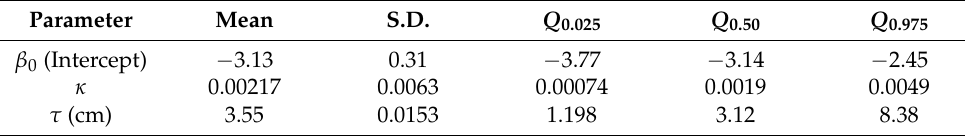
Table 1. Posterior distribution of the parameters using the complete